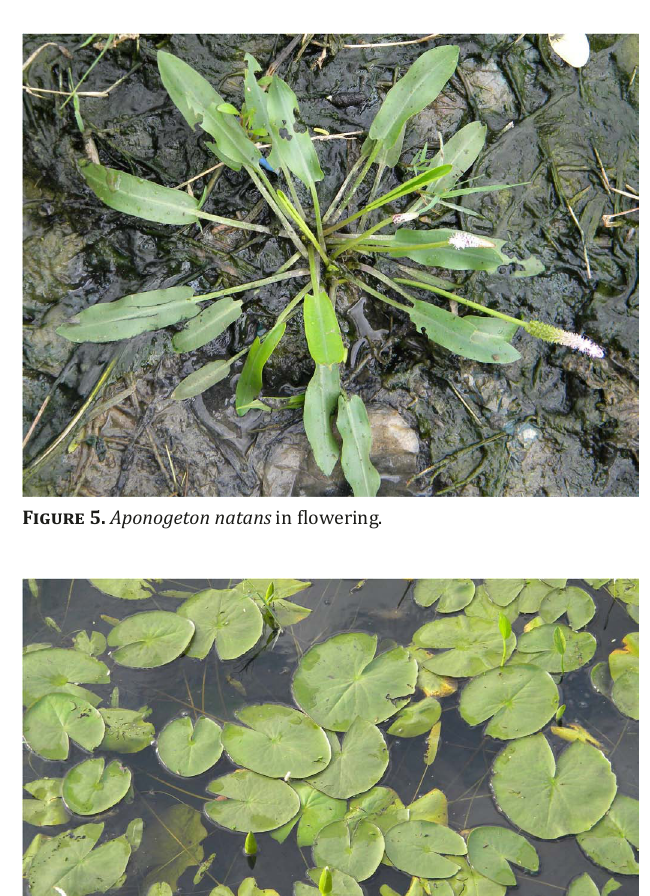
Figure 7. Nymphaea nouchali